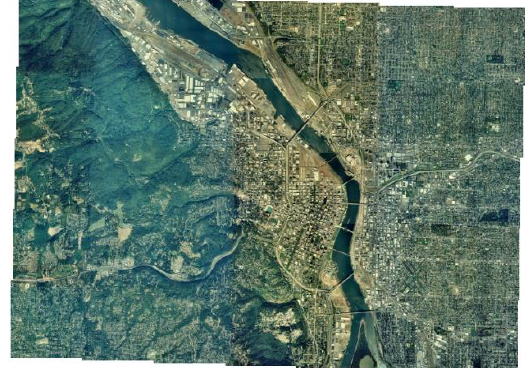
Fig.3.5 Color balance result: Color Grid Target